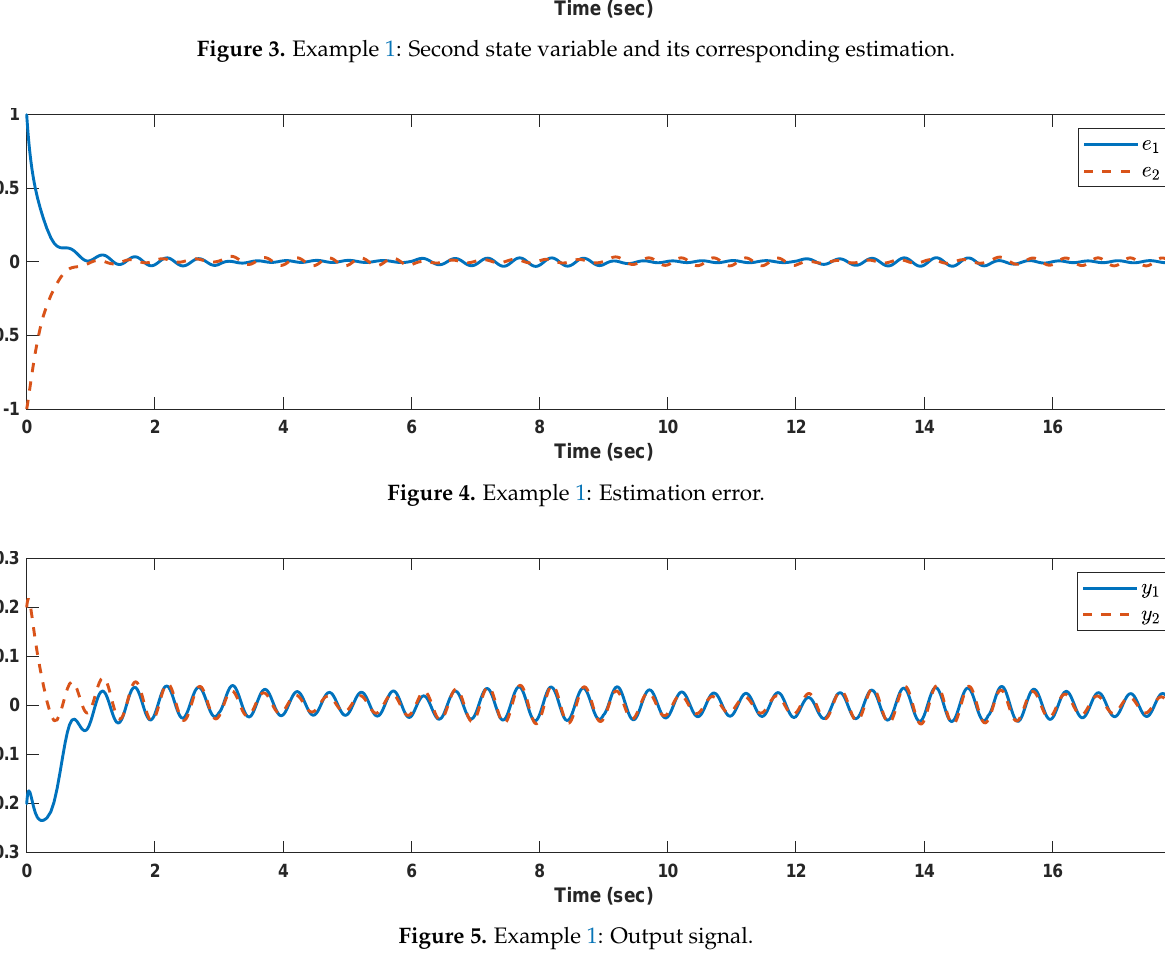
Figure 5. Example 1: Output